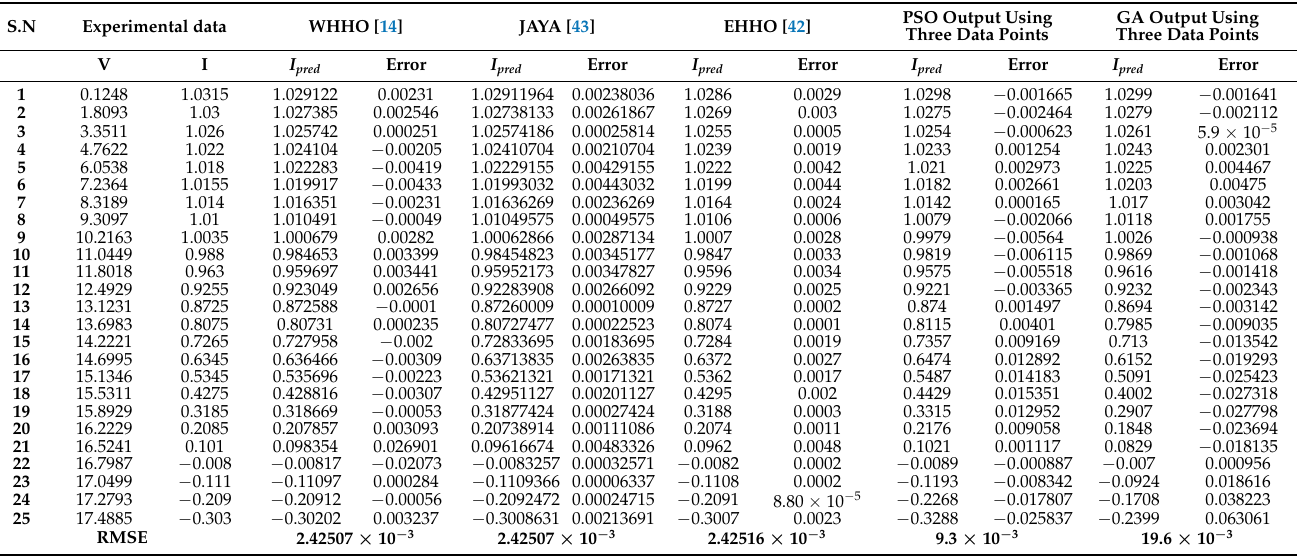
Table 6. Comparison of the estimated output current for the the proposed methodology and the reference model for the PWM201